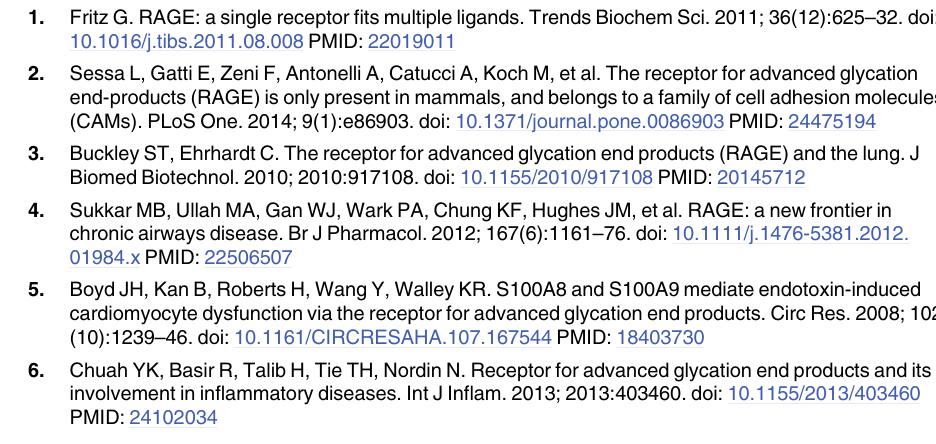
S1 Fig. Original unadjusted blots of Fig 2: M-RAGE is resistant to shedding. Twenty μg of lysate from one Rage-/- and one wild type (wt) lungs and 35 μg of lysate or supernatants from R3/1 cells transfected with the empty vector (pcDNA), FL-RAGE or M-RAGE were probed with the indicated antibodies against RAGE. Because of different levels of RAGE expression in lung and R3/1 cells, long and short exposure of the same membranes are shown. GAPDH or Beta-actinwere used as loading control. In all panels, nonspecific bands ( (cid:3) ) are indicated. (TIF) S2 Fig. Original unadjusted blots of Fig 4: effect of ADAM10 activity on FL-RAGE and M-RAGE cleavage. R3/1 cells were transfected with the indicated vectors, treated or not with an ADAM10 inhibitor (GI), and processed as describedin Materials and Methods. Representa- tive WB of cell lysates (50 μg) and supernatants of R3/1 cells. Because of the variable levels of cRAGEs in the supernatants of R3/1 cells, short and long exposures of the same membrane are shown. Beta-actinand red Ponceau staining were used as loading control for cell lysates and supernatants, respectively. (TIF) S3 Fig. Original unadjusted blots of Fig 5: PMA enhancesFL-RAGE but not M-RAGE shed- ding. A10 ko and A10 wt MEFs were transfected with the indicated vectors, treated or not with PMA for 3 hours and processed as describedin Materials and Methods. Representative WB of cell lysates (40 μg) and supernatants of MEFs. Beta-actin and red Ponceau staining were used as loading control for cell lysate and supernatant,